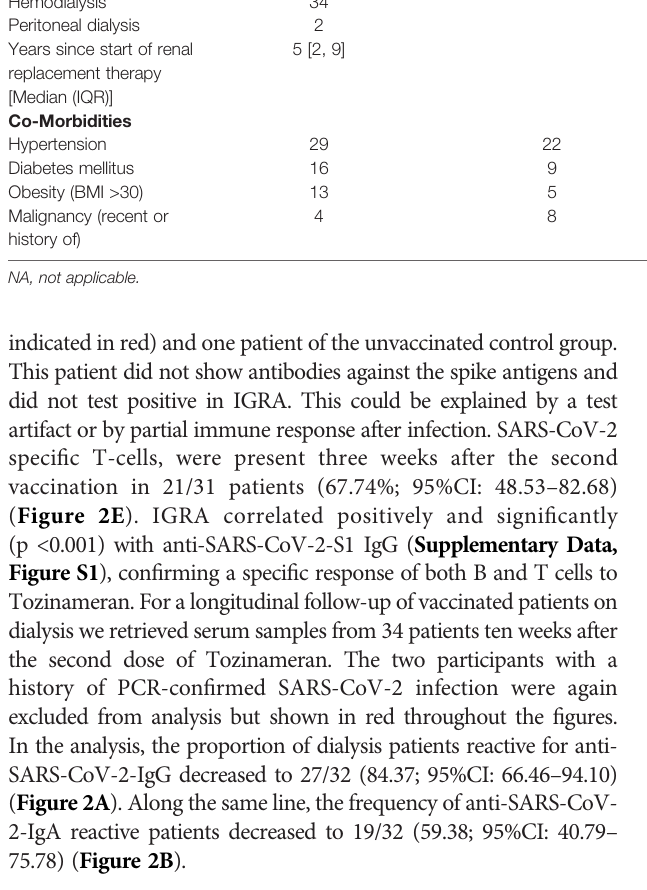
Statistical group difference (p-value) Vaccinated DP vs Vaccinated DP vs vaccinated-non-DC unvaccinated